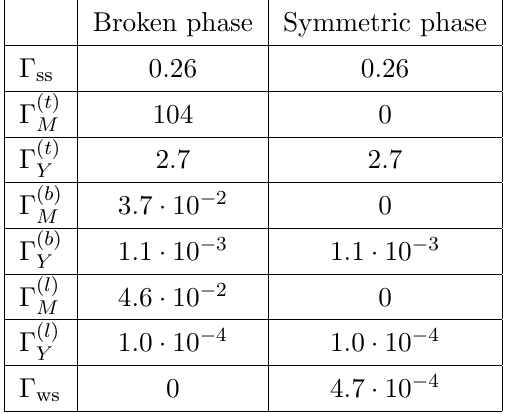
Table 5 . Asymptotic values of the interaction rates in the broken and symmetric phase. All rates are in GeV. The relaxation rates (cid:0) ( f ) are a function of the bounce solution (cid:30) b and vary over the M bubble